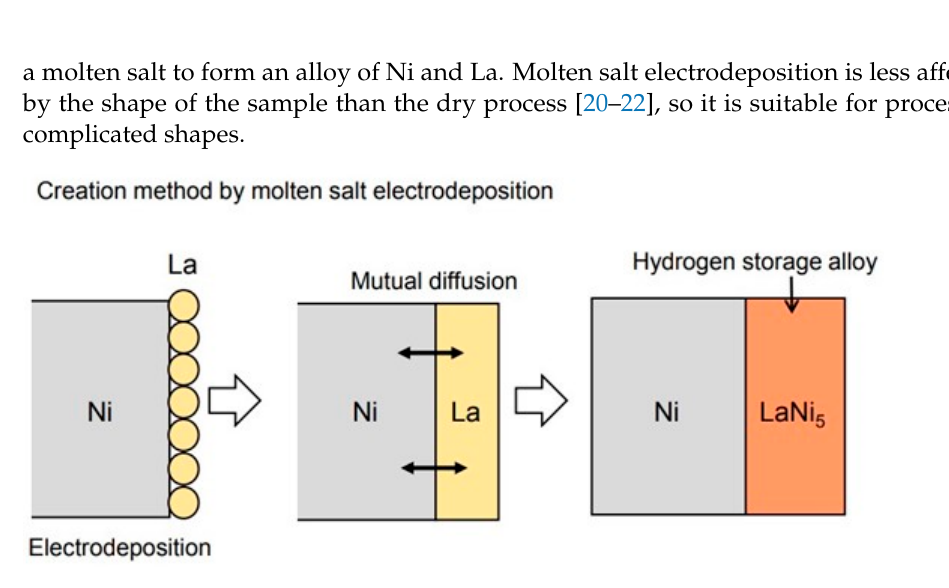
Figure 1. Schematic diagram of formation of LaNi 5 hydrogen storage alloy by La electrodeposition.